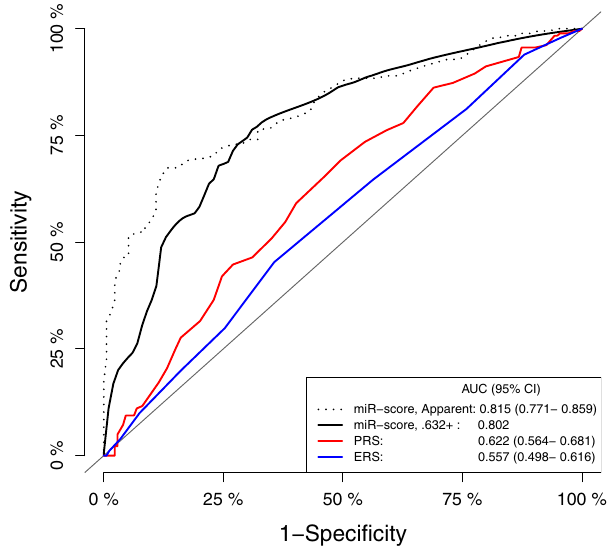
Fig. 2 Performance of risk scores for predicting CRC risk. Receiver operating characteristic curves for CRC risk prediction in prospective set participants with all scores available ( N cases/controls = 181/174) according to microRNA risk score (miR-score), polygenic risk score (PRS) and environmental risk score (ERS).